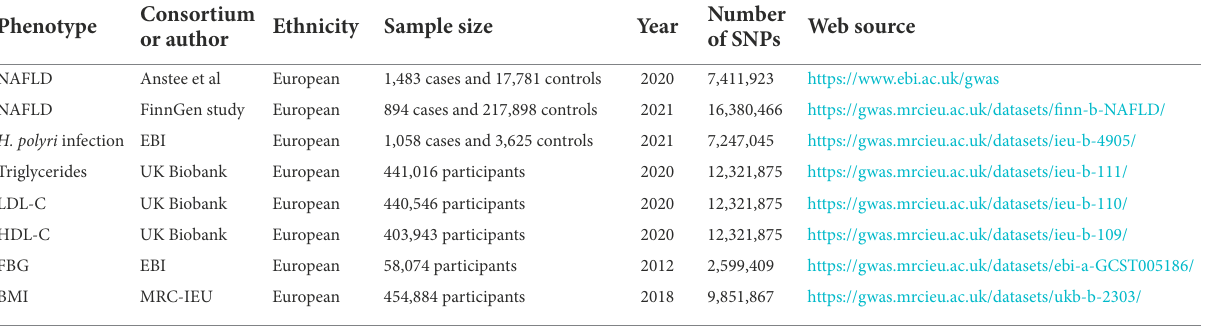
TABLE 1 Details of the studies included in the Mendelian randomization